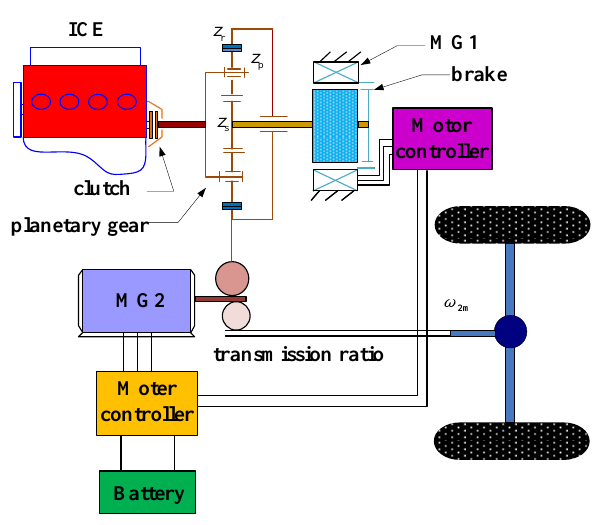
Figure 2. The structure diagram of the Prius power transmission system.